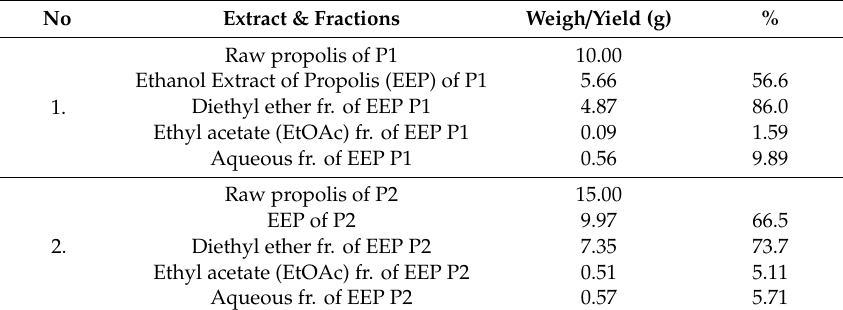
Table 1. Extracts and Fractions obtained from T. sapiens propolis.